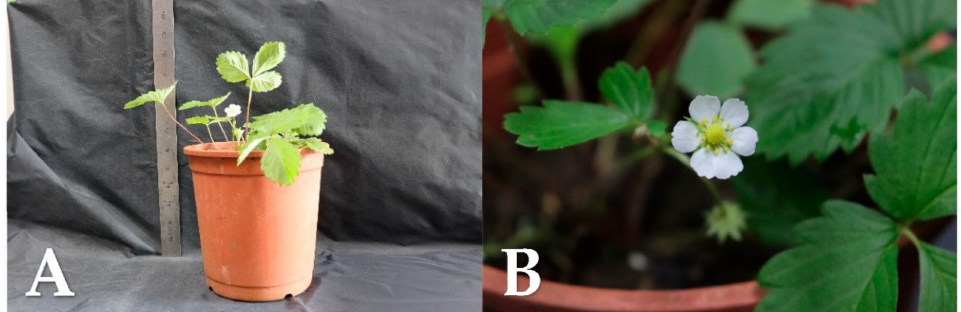
Figure 5. Acclimatization of wild strawberry ( Fragaria vesca ) plants. ( A ) The strawberry after three months of cultivation; ( B ) flowers blooming after strawberry